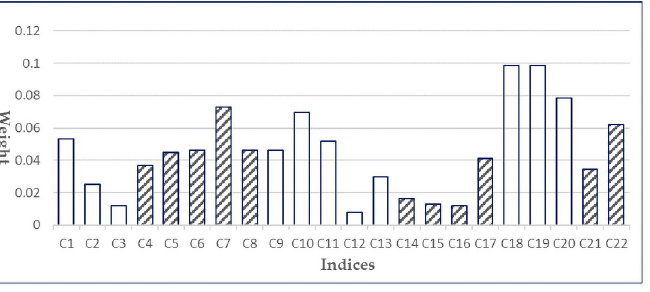
Fig 1. The average weights of tertiary indices in China’s industrial high quality development index